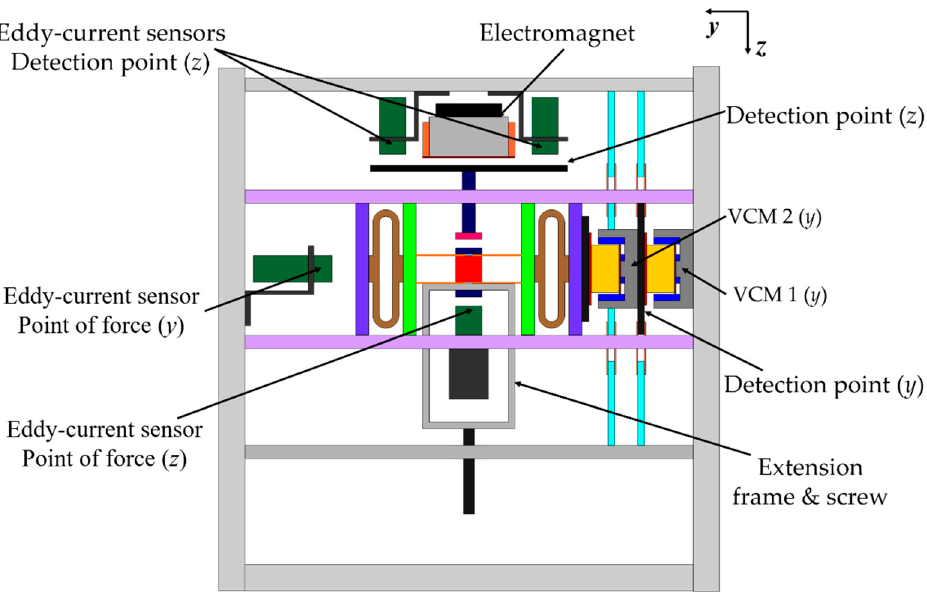
Figure 7. View of the developed system [23].